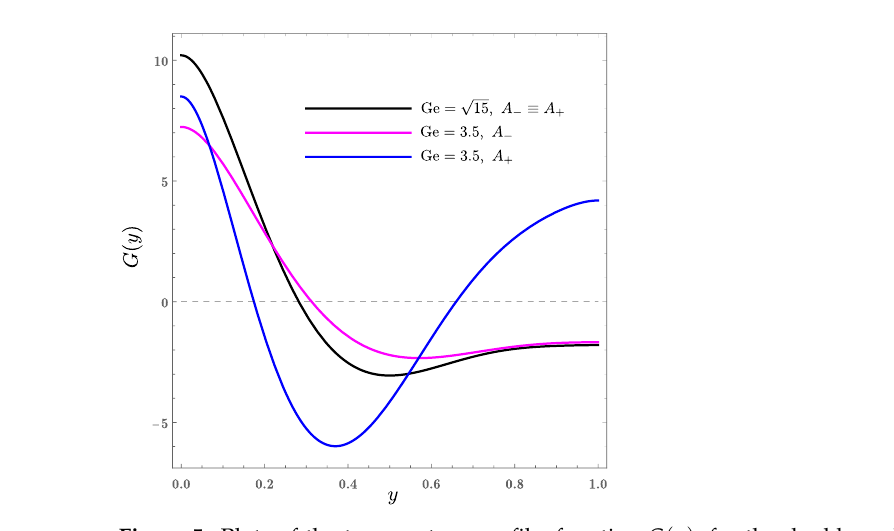
Figure 4. Plots of the temperature profile, function G ( y ) , for the dual branches A − and A + and different values of Ge.